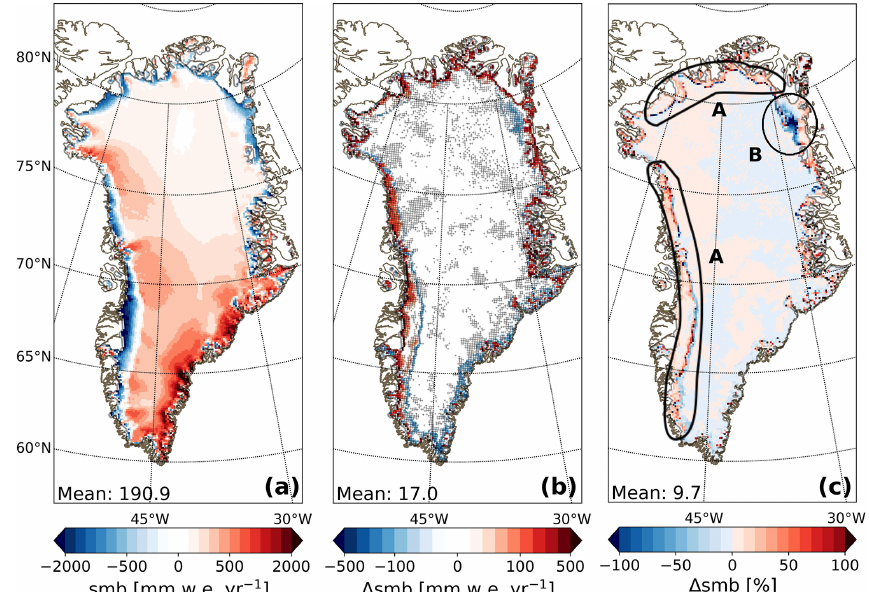
Figure 8. (a) Annual average surface mass balance between 2006 and 2015 for Rp3, with a linear color scale with a step size of 100mmw.e.yr − 1 between − 500 and 500 and 500mmw.e.yr − 1 elsewhere. (b) SMB difference (Rp3 − Rp2). A linear color scale with a step size of 100mmw.e.yr − 1 between − 500 and − 100 and between 100 and 500mmw.e.yr − 1 is used and 20mmw.e.yr − 1 elsewhere. The hatched areas show statistical significance. (c) The relative difference between Rp3 and Rp2. Patterns A and B are discussed in the